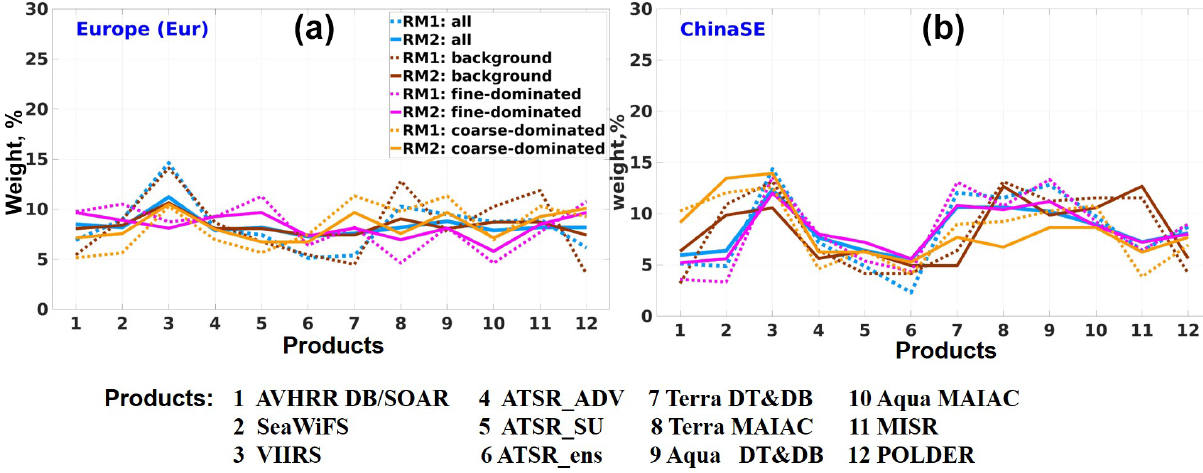
Figure 7. (a) Weights of each product obtained with RM1 and RM2 for Europe and (b) ChinaSE for different aerosol types (all, background, fine-dominated and coarse-dominated). For all regions, see Fig. S11.